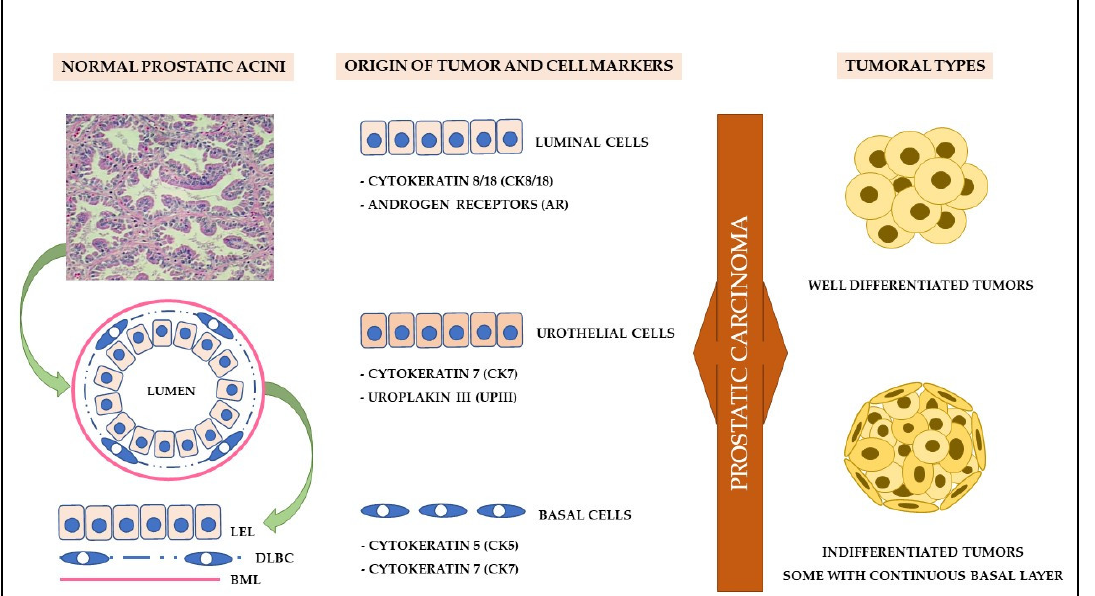
Figure 3. Cellular origin and tumor initiation of the canine PC. The normal prostate of the dog has prominent acini with a smaller stromal component and a discontinuous basal cell layer (DLBC). Thus, canine PC can originate from luminal epithelium layer (LEL), with immunoexpression for low molecular weight cytokeratins (CK8/18) and AR; or originate from basal cells, with immunostaining for high molecular weight cytokeratins (CK5 and CK7), which is more frequent in tumors with a lower degree of cell differentiation, which may also have a continuous basement membrane. In addition to the basal and luminal cells of the prostatic acini, the canine PC may originate from urothelial cells present in the prostatic ducts that empty into the urethral canal, which express CK7 and UPIII. BML: Basement membrane